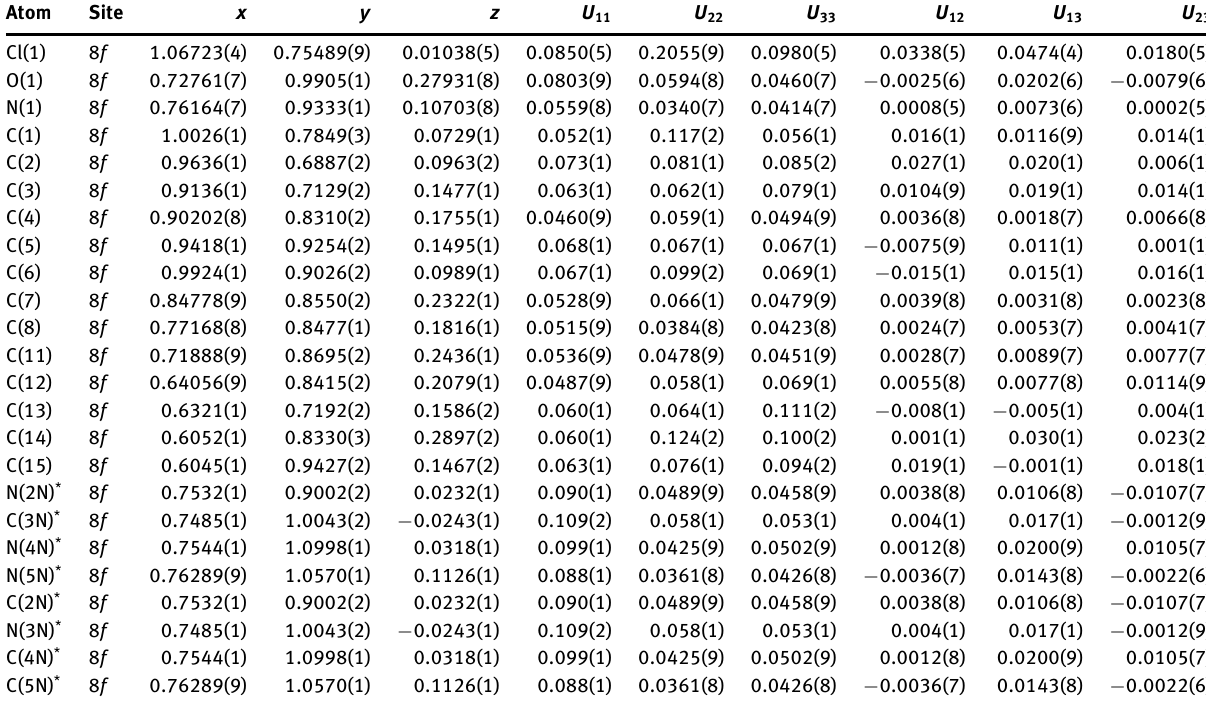
Table 3: Fractional coordinates and atomic displacement parameters (Å 2